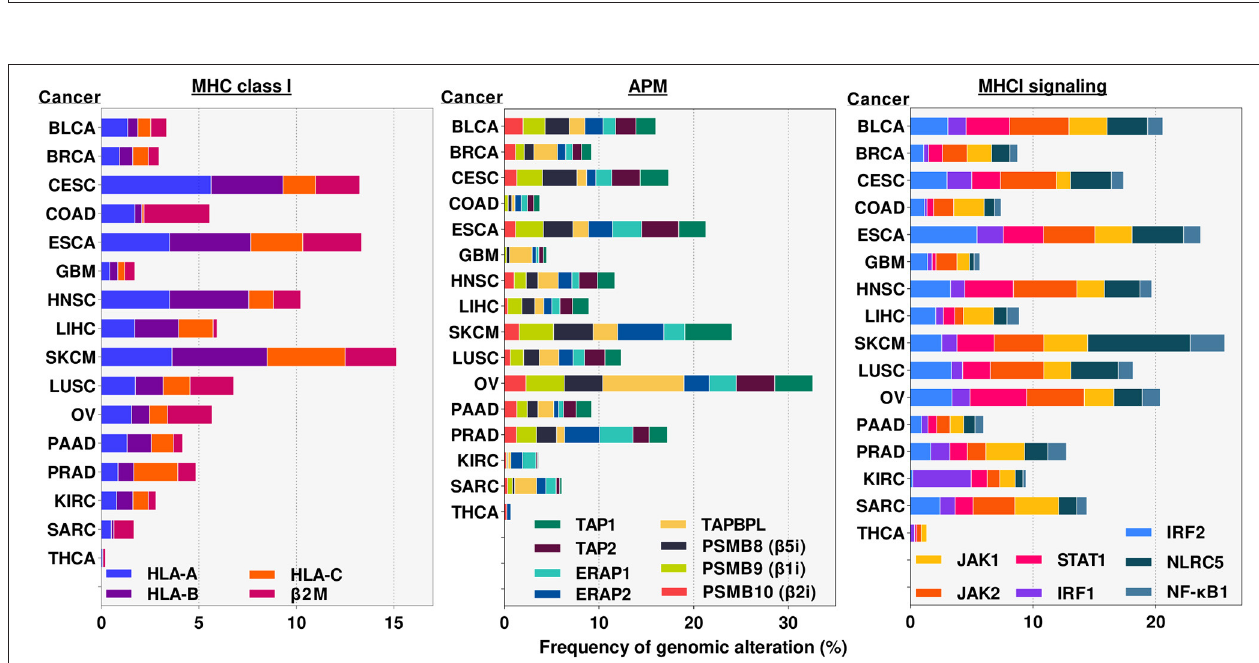
Frontiers in Immunology |